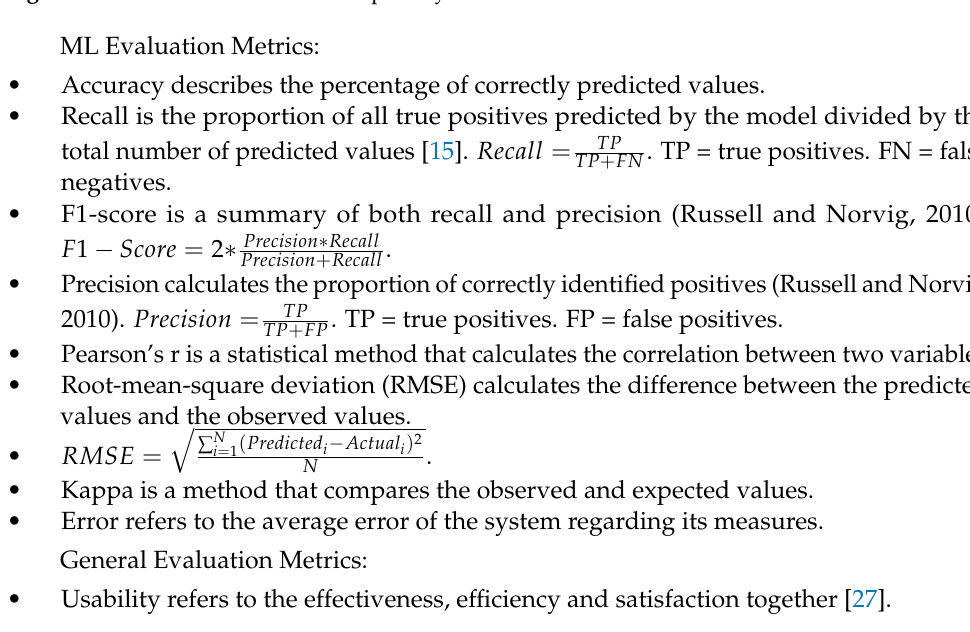
Figure 9. The evaluation metrics adopted by the selected